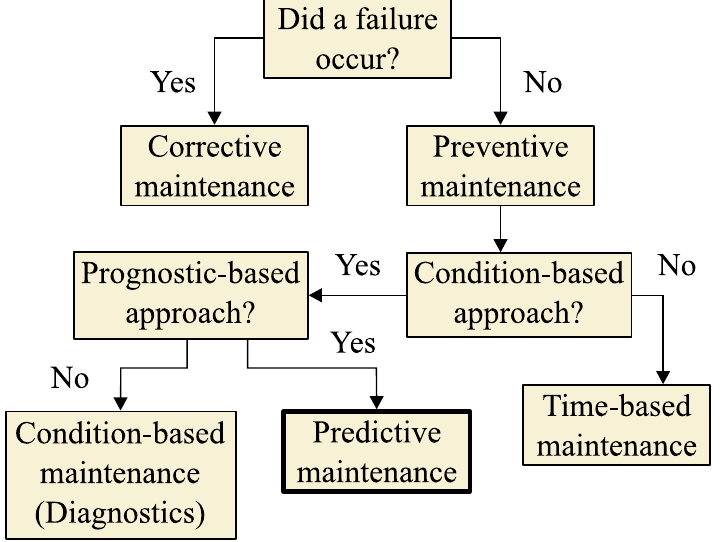
Figure 1. Interrelation of maintenance strategies [1].